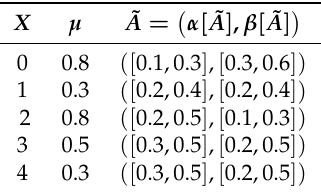
Table 4. Tabular representation of A = (cid:104) µ , ˜ A (cid:105)